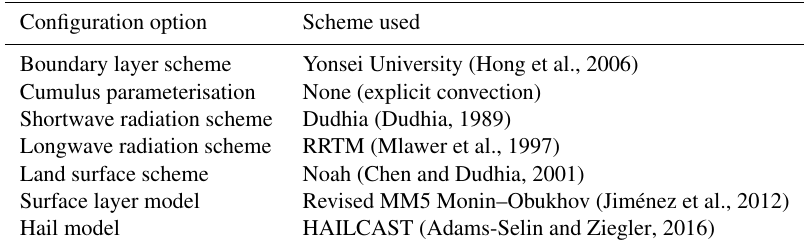
Table 2. Schemes used in the WRF model in this